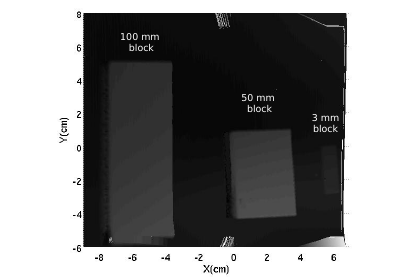
Figure 15. Comparative chart for average errors. X-axis shows the measured objects and Y-axis the average error in mm .